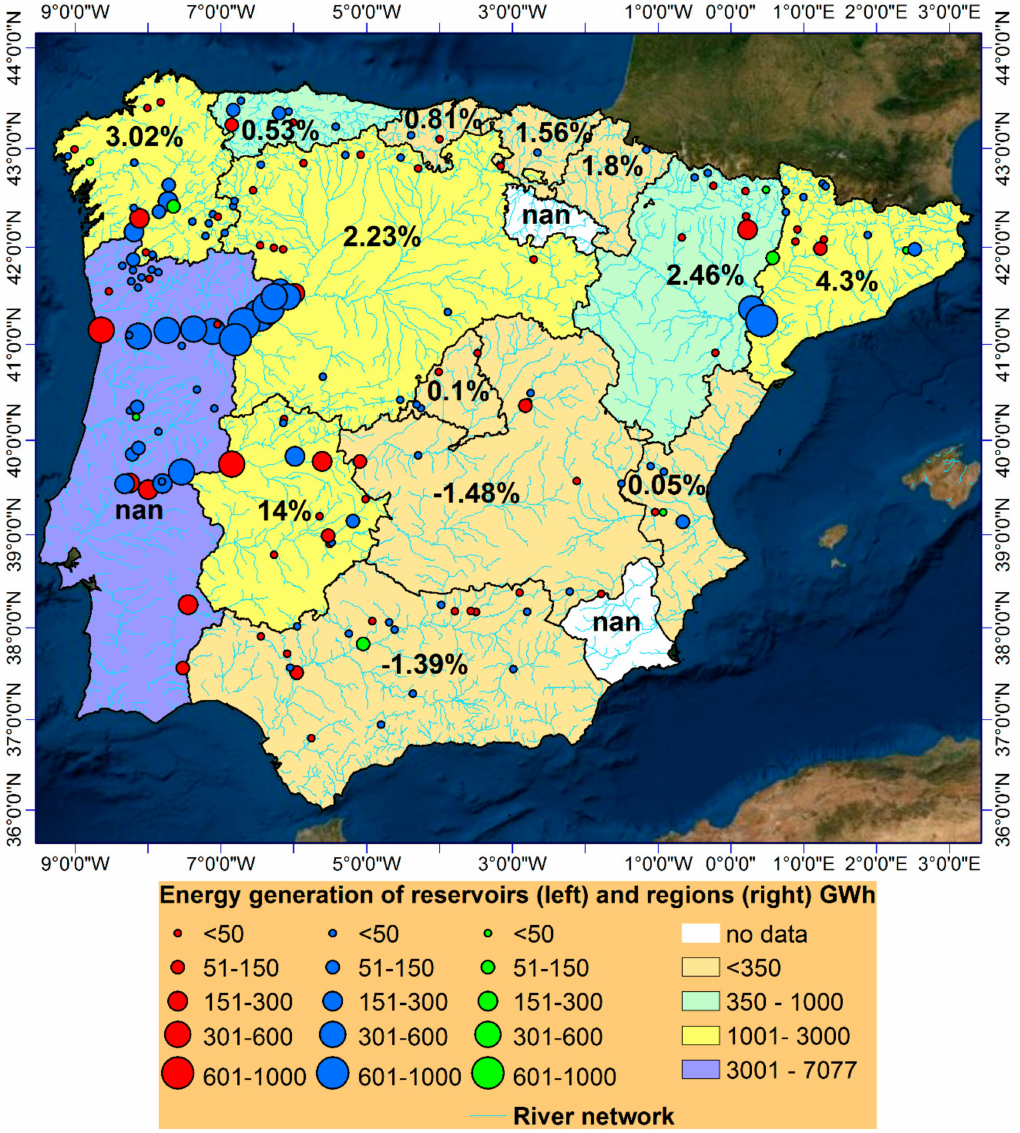
Figure 14. Average energy generation (2007–2016) over studied reservoirs and regions in the Iberian Peninsula (GWh) and the average hydropower generation change in percent for the 2007–2016 period between reported (source: www.ree.es) and simulated generation. Red circles correspond to the convex, blue circles to the conical and green circles correspond to the concave